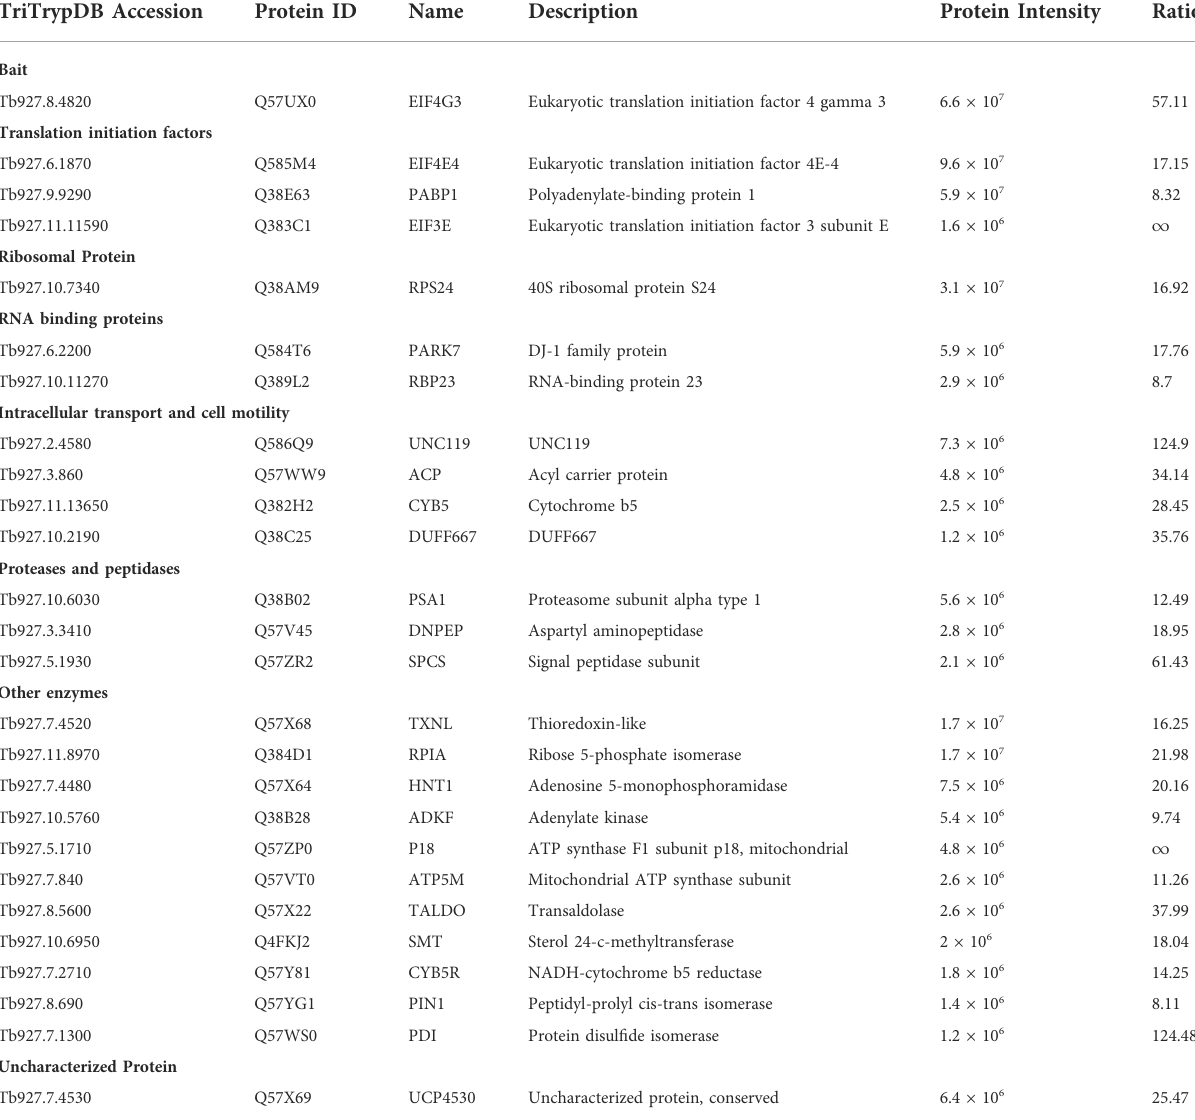
TABLE 4 Most enriched proteins co-precipitated with the eYFP-tagged EIF4G3 in Trypanosoma brucei procyclic